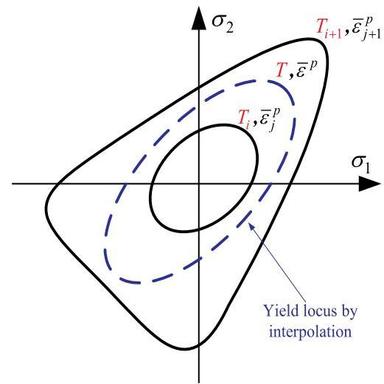
The temperature dependent discontinuous constitutive framework.